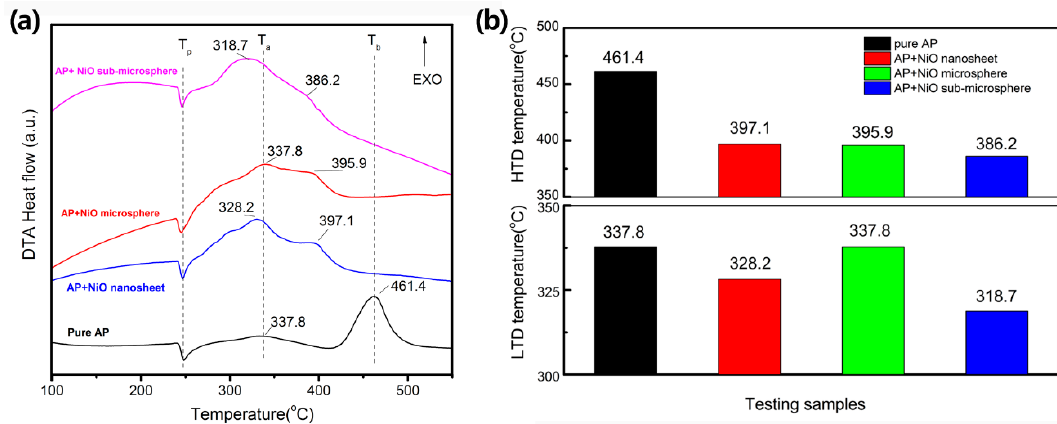
Figure 7. ( a ) Differential thermal analyzer (DTA) curves of pure ammonium perchlorate (AP) and AP mixture with as-prepared NiO additives; ( b ) histogram of high temperature decomposition (HTD) and low temperature decomposition (LTD) temperatures in ( a ).